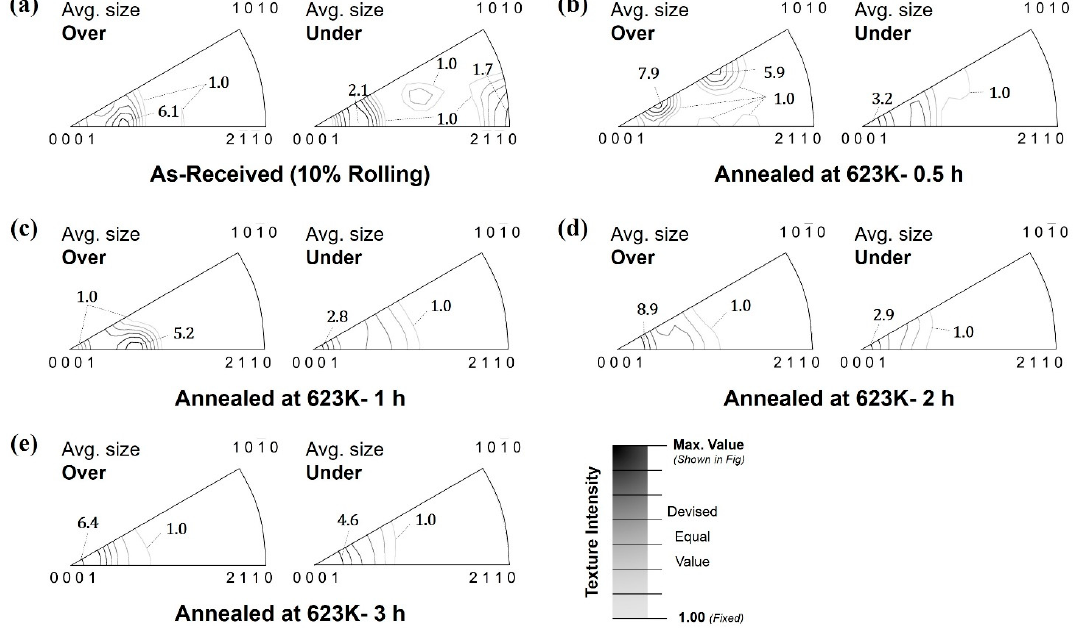
Figure 8. IPFs of the specimen ( a ) rolled with 10% reduction and after annealing at 623 K for ( b ) 0.5, ( c ) 1, ( d ) 2, and ( e ) 3 h.